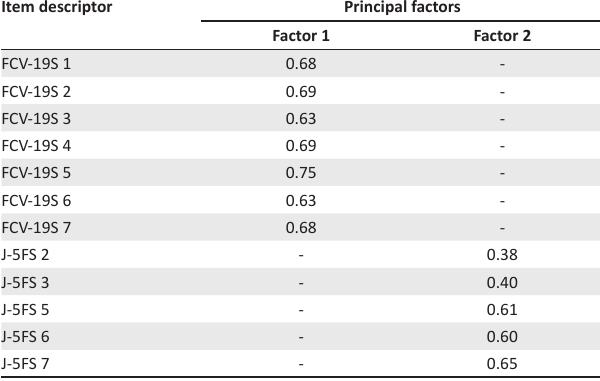
TABLE 3: Factor matrix of the Fear of COVID-19 Scale and the Jackson-5 Fear Scale. Item